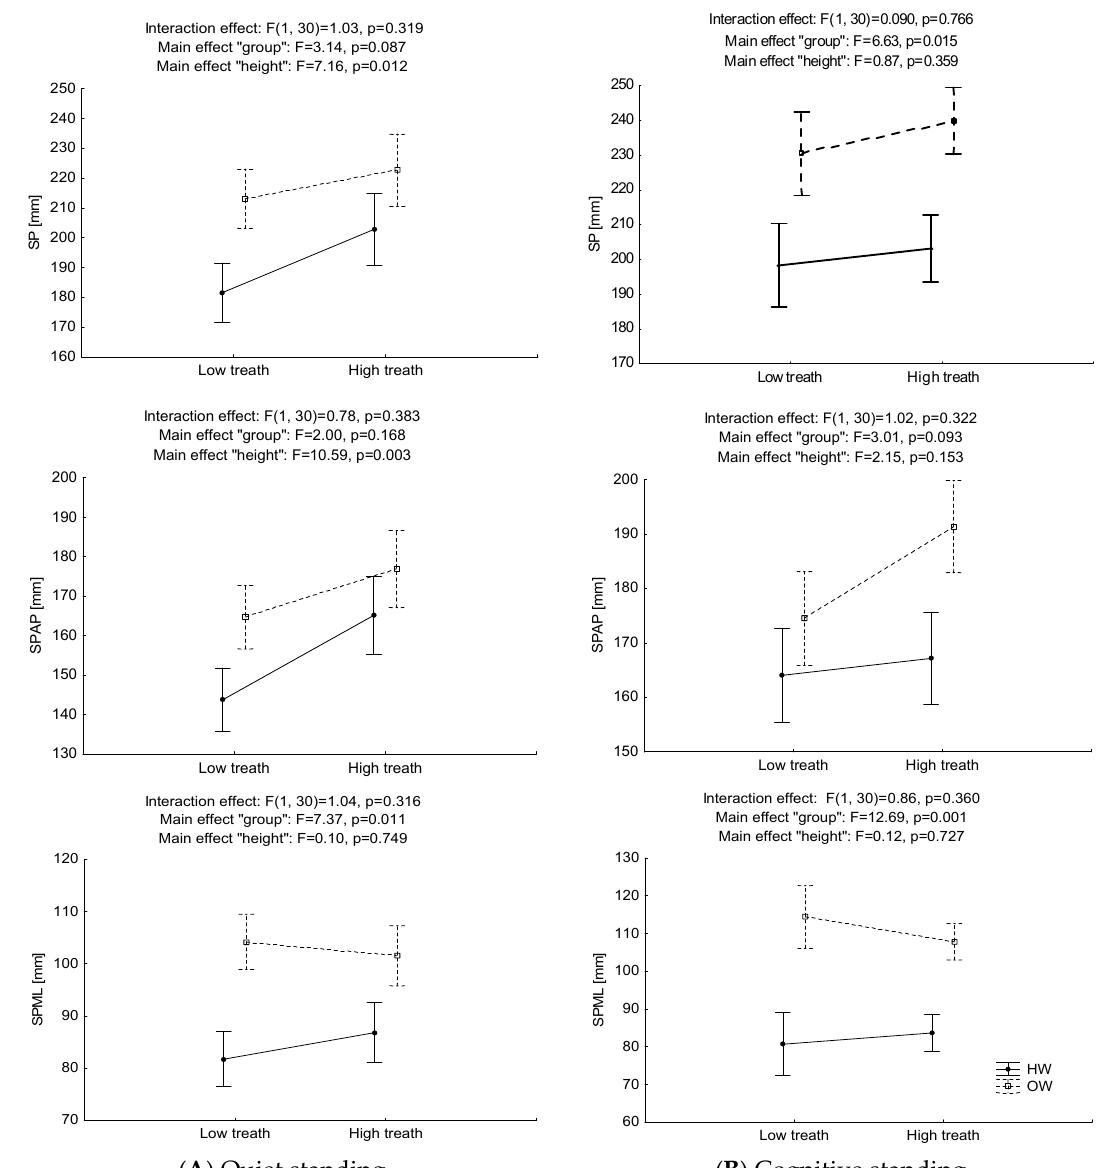
Figure 3. Mean values and standard error of measurements for sway path of center of pressure (COP) displacements (SP) and its components in anteroposterior (AP) and mediolateral (ML) directions for “height” factor (low-high threat) and “group” factor (at-height workers—HW and office workers—OW) for quiet standing ( A ) and cognitive standing ( B ).